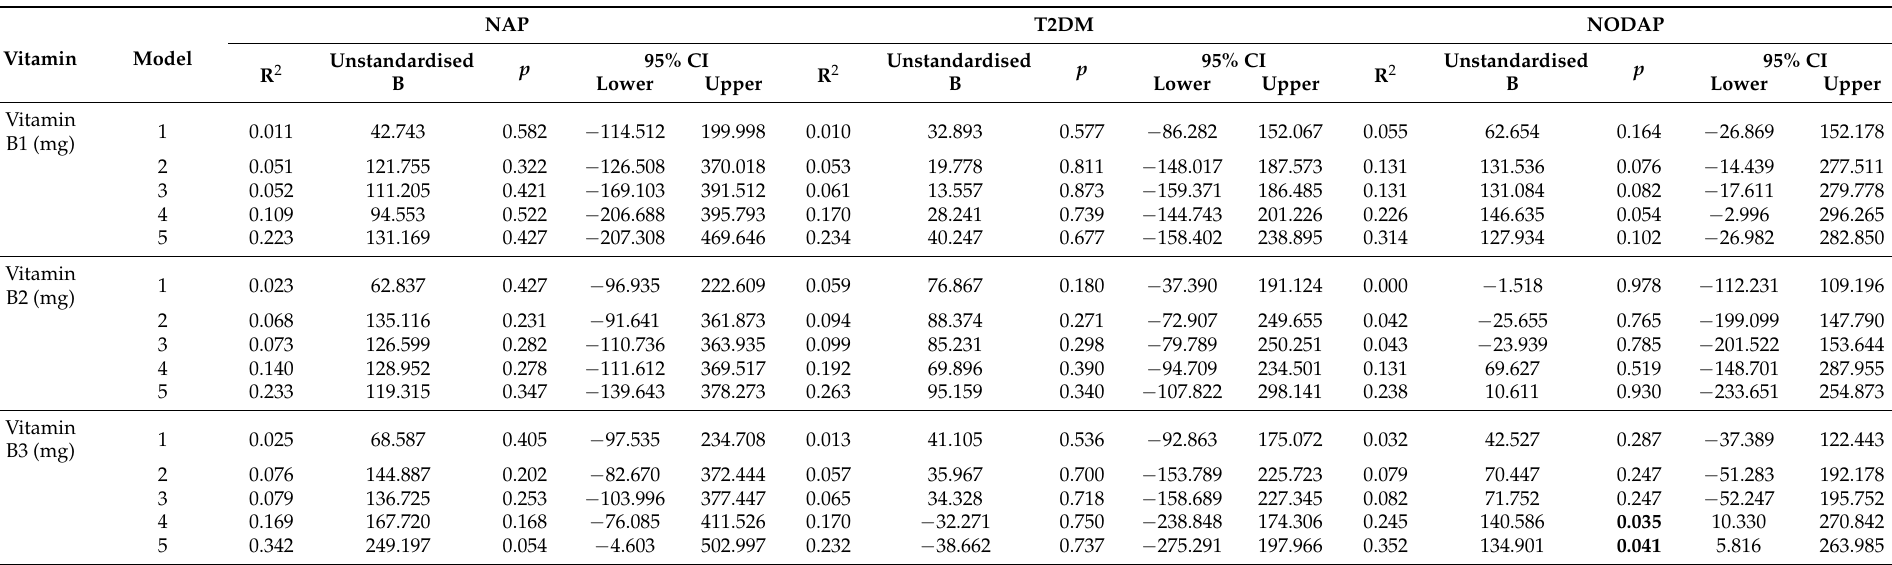
Table 5. Associations between habitual water-soluble vitamin intake and HOMA- β in the study